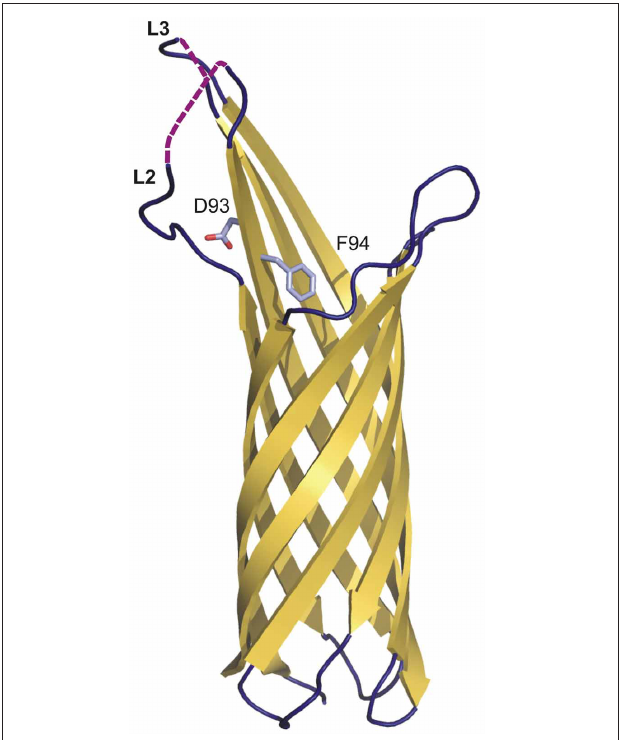
FIGURE 4 | The crystal structure of Ail from Y. pestis . Topology diagram of the Ail structure (3QRA) with partially disordered loops two (L2) and three (L3). The invisible loop regions are marked on the picture as violet dashed lines. Residues D93 and F94 (crucial in serum resistance and invasion) are shown as